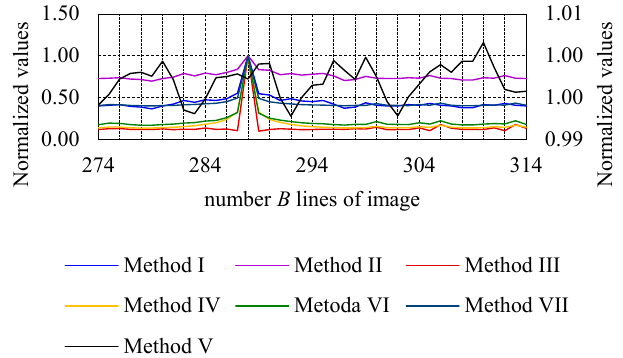
Figure 17. Normalized values (in relation to the maximum value) of the variability of measures as a function of the number of image lines, supporting the determination of the correct number of lines of the image reproduced for the source image in the form of a picture from Figure 7d—menu of multifunctional device, frequency of the reveal emission signal f o = 235 MHz, reception bandwidth BW = 10 MHz, correct number of lines B Corr = 288 . Table 4. Normalized values (in relation to the maximum value) of the variability of measures as a function of the number of image lines, supporting the determination of the correct number of lines of the image reproduced for the source image in the form of a picture from Figure 7d.